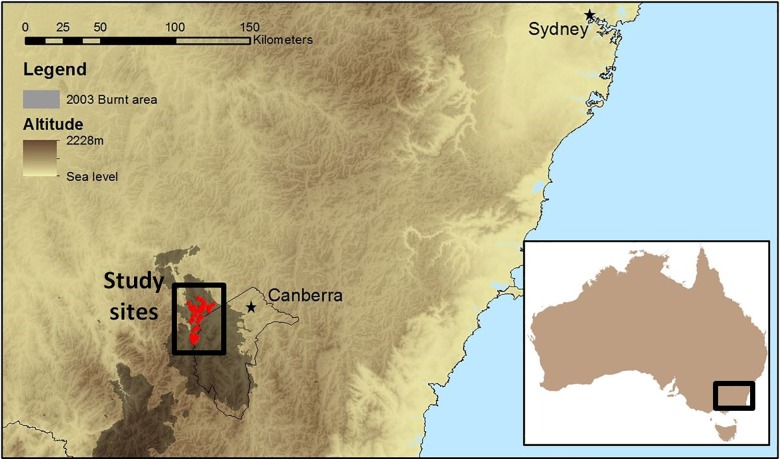
Location of the study sites (open circles) in relation to Canberra, Sydney and the area affected by the 2003 bushfires (shaded).